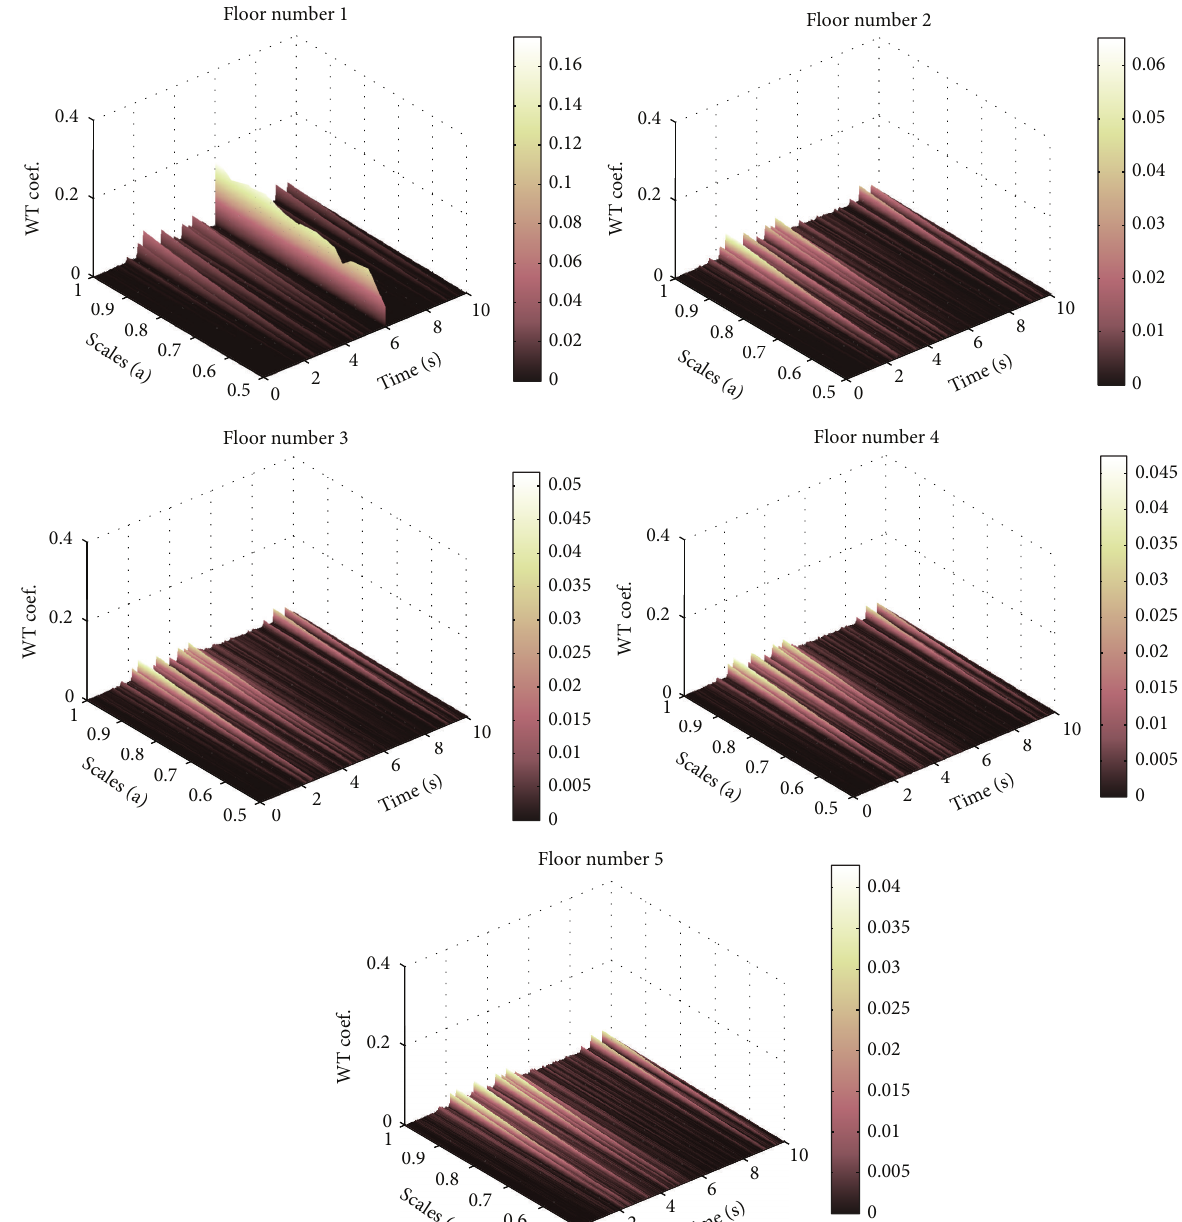
Figure 5: Damage detection for each floor under seismic